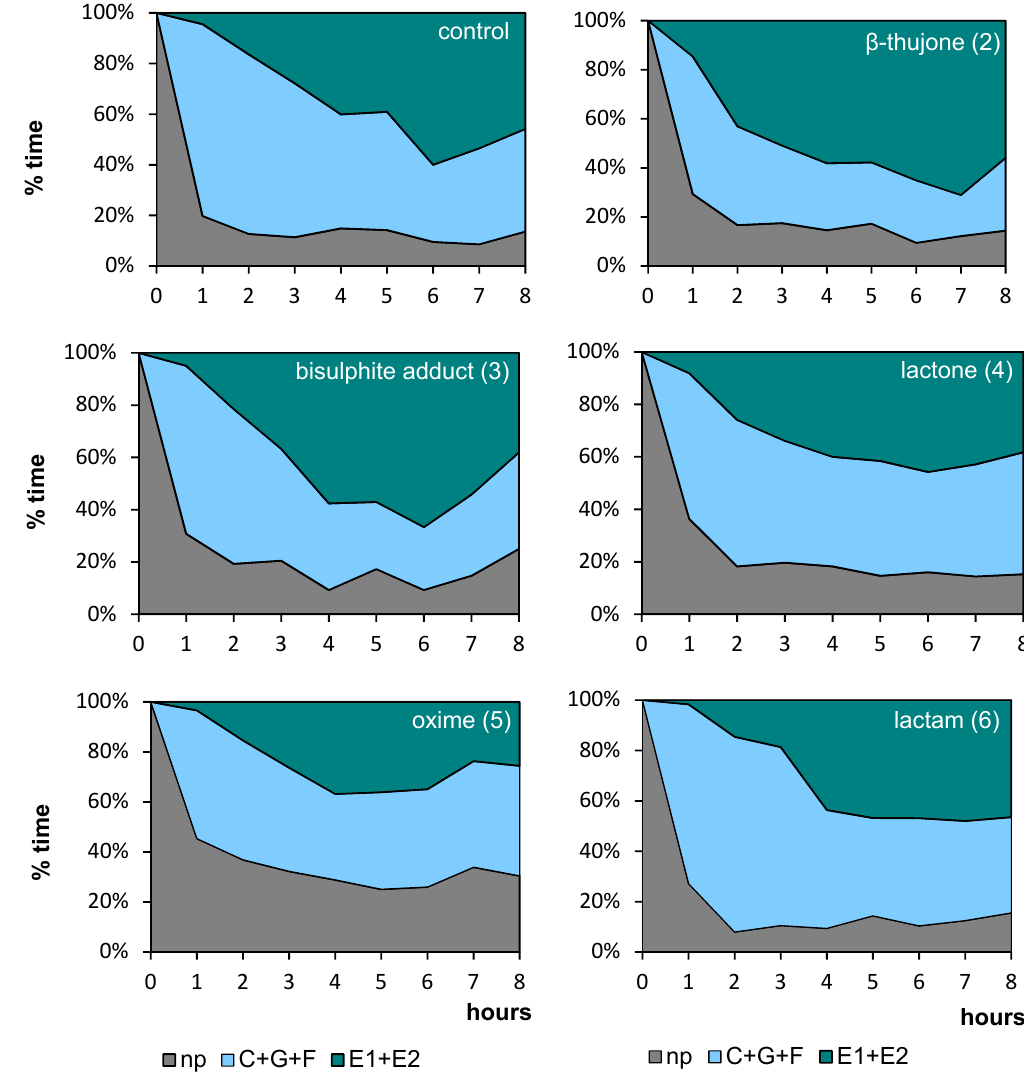
Figure 2. Temporal evolution of the probing behavior of Myzus persicae on Brassica rapa subsp. pekinensis treated with (+)- β -thujone ( 2 ) and its derivatives bisulfite adduct ( 3 ), lactone ( 4 ), oxime ( 5 ), lactam ( 6 ), expressed as the proportion of time spent on different stylet activities during the 8 hr Electrical Penetration Graph (EPG) experiment: np, non-probing; C+G+F, probing in non-phloem tissues (probing in non-vascular tissues + xylem phase + undefined stylet activities), E1+E2, total phloem phase (watery salivation + sap ingestion); The same plant was used to maintain the aphid stock culture; n = 15.